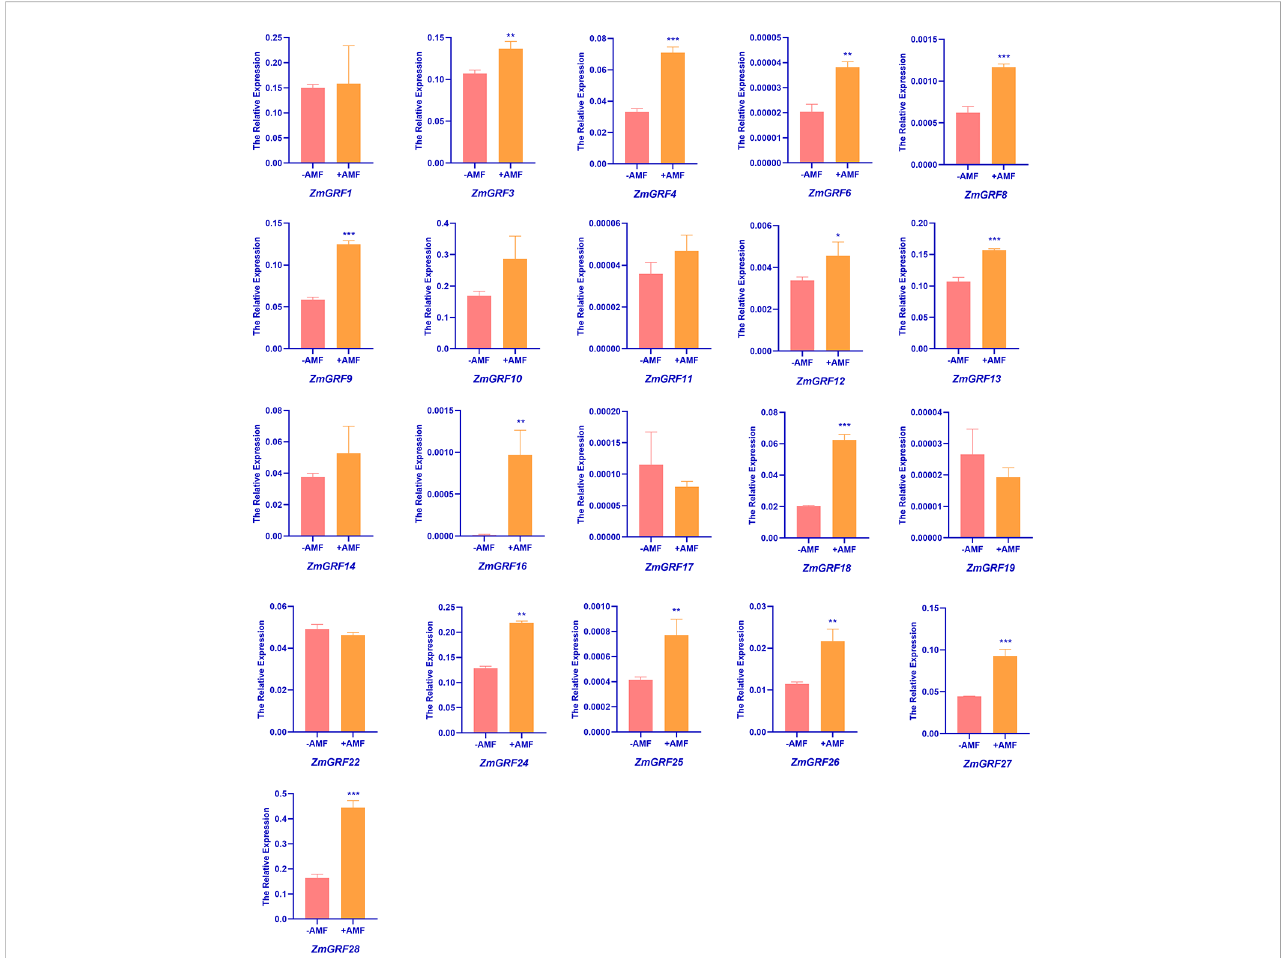
FIGURE 6 Relative expressions of 14-3-3 genes in roots of wild-type. Maize was inoculated with AM symbiosis and sampled 60 days after inoculation. (p*<0.05 、 p**<0.01 、